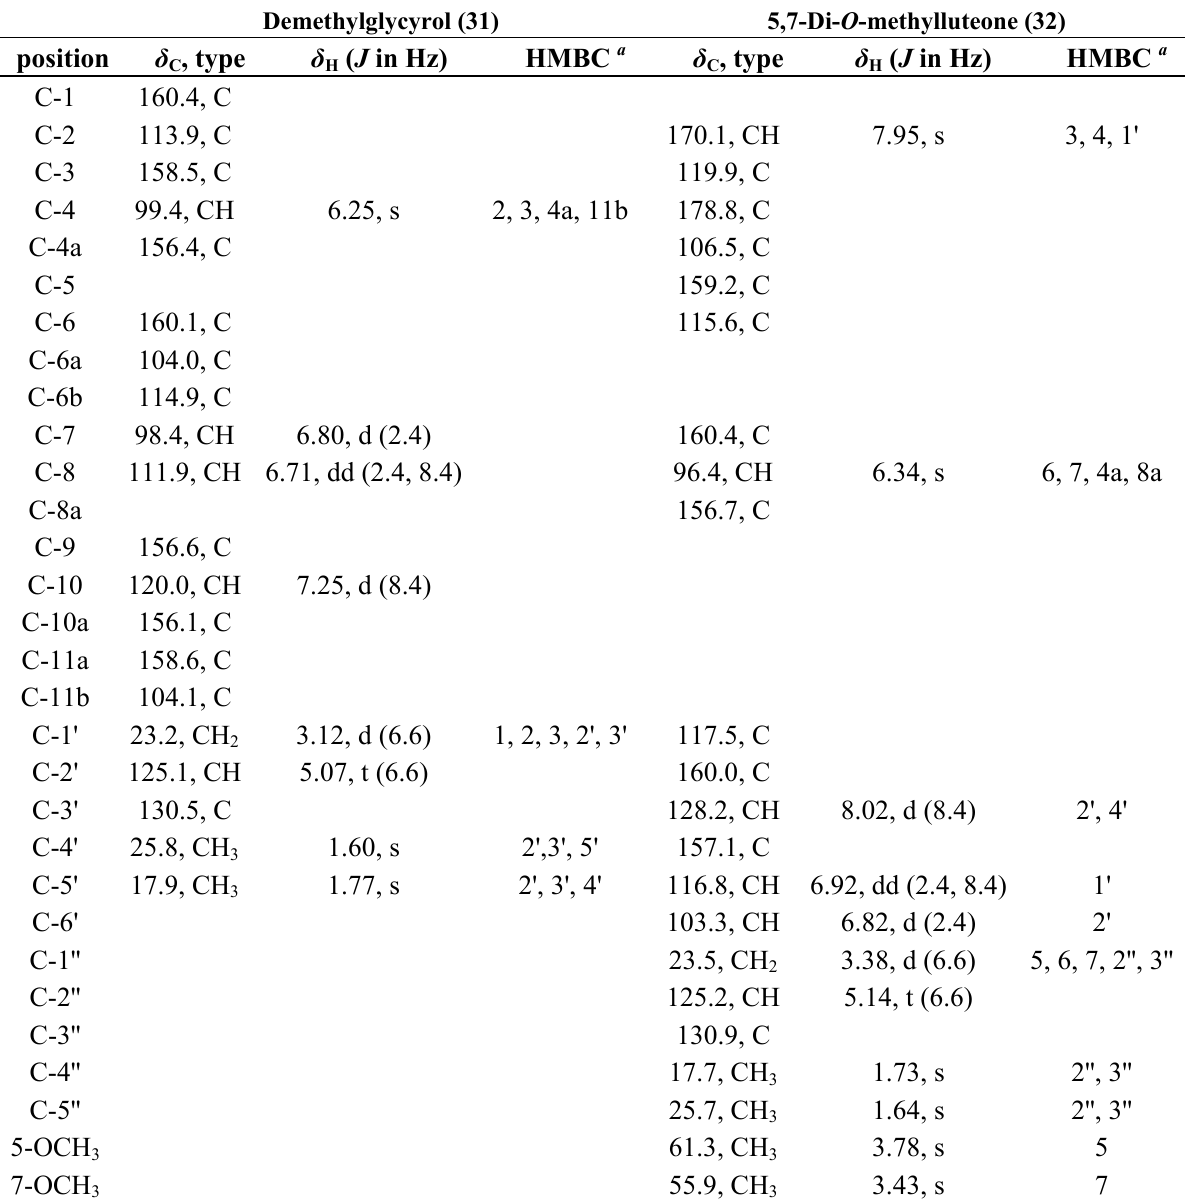
Table 1. 600 MHz NMR Spectroscopic Data for Demethylglycyrol ( 31 ) (acetone-d